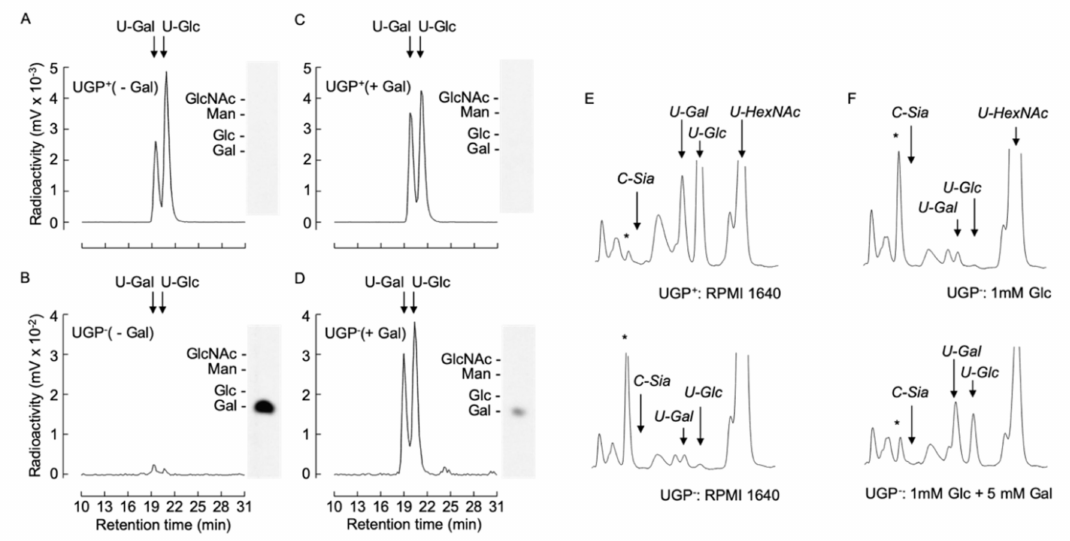
Figure 6. [6- 3 H]galactose metabolism and UDP-Glc / Gal steady state levels in UGP + and UGP − cells. ( A – D ). UGP + cells ( A , C ) and UGP − cells ( B , D ) were incubated for 16 h in glucose-free medium